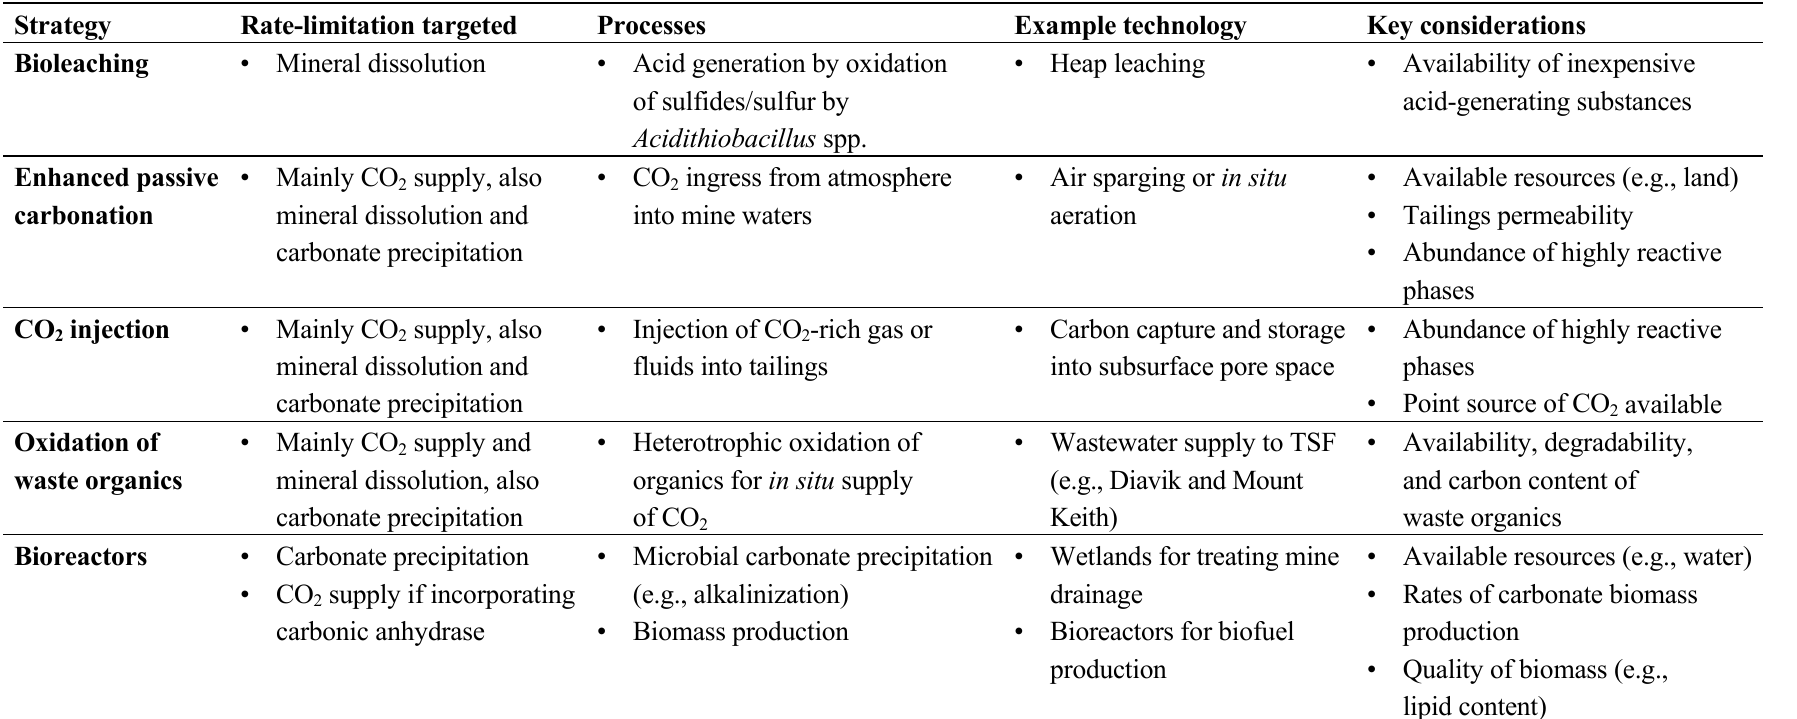
Table 2. Summary of accelerated carbon mineralization